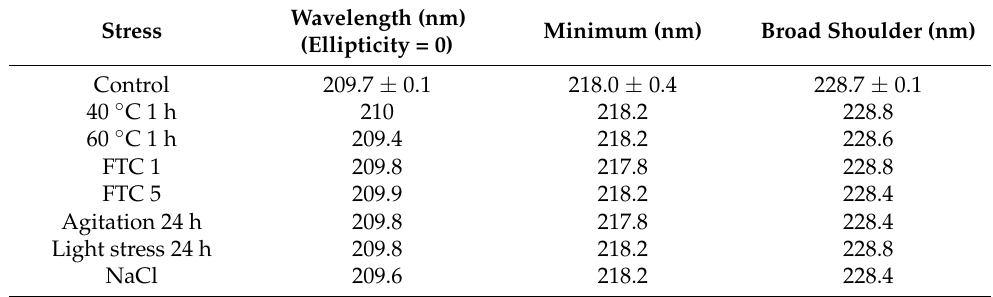
Table 1. Secondary structures of nivolumab samples tracked by changes in the Far UV CD spectra.